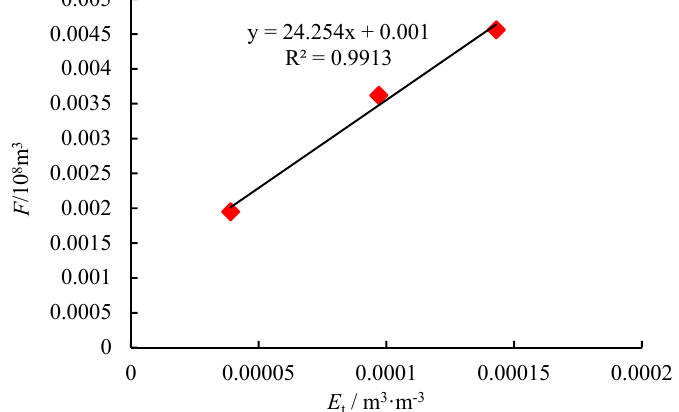
Figure 6. Well-controlled dynamic reserves estimation fi tt ing diagram of well B-15.